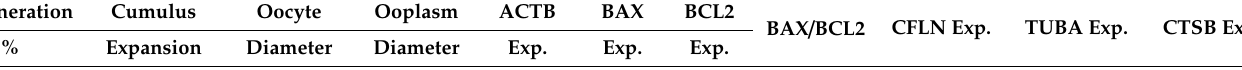
Table 4. Pearson’s correlation coe ffi cient (r) between oocyte parameters and mRNA transcripts’ expression. %